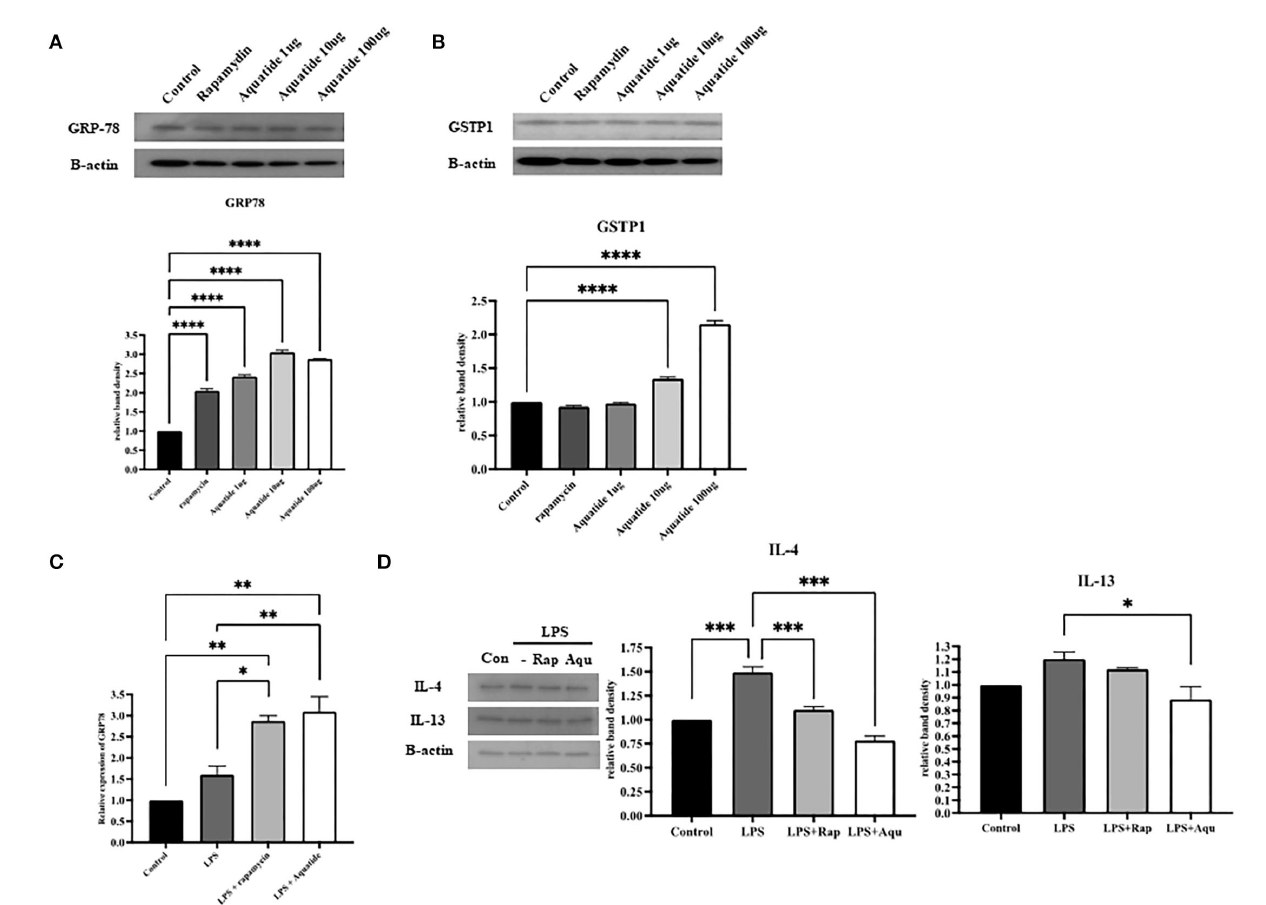
FIGURE5 Preconditioning-induced autophagy reduces pro-inflammatory cytokines through GRP78 activation in canine keratinocyte cells. The antioxidant-related protein levels of (A) GRP-78 and (B) GSTP1 and mRNA levels of (C) GRP-78 were assessed by western blot and real-time PCR. (D) pro-inflammatory cytokines (IL-4 and IL-13) were assessed by western blot analysis. Statistical significance was determined using ANOVA and Tukey’s multiple comparison tests. * P < 0.05, ** P < 0.01, *** P < 0.001, and **** P <